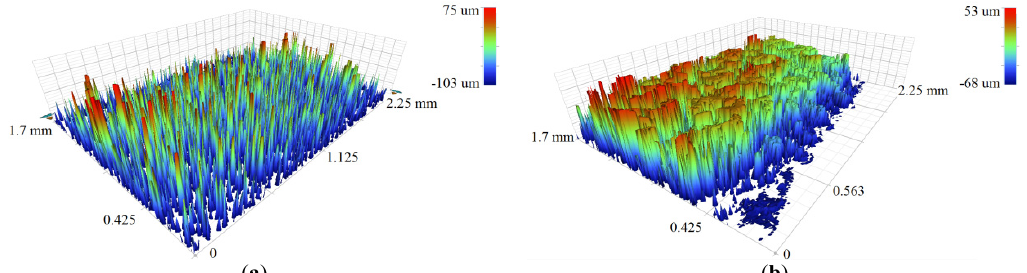
Figure 13. Three-dimensional (3D) optical images of the surface topography of ( a ) as-built and ( b ) laser polished samples.